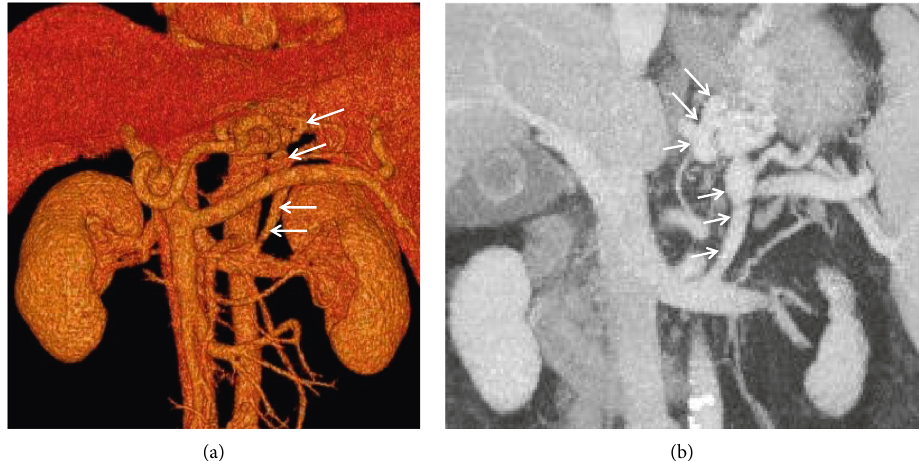
Figure 10: Gastrorenal shunt. A 62-year-old male with a four-year history of unexplained liver cirrhosis presented with recurrent hematemesis. The contrast-enhanced CT scan on the portal vein phase demonstrated that gastrorenal shunt (white arrow) manifested as enhancement of abnormally dilated vessels originating from the gastric vein to the left renal vein. (a) Three-dimensional reconstruction; (b) coronal contrast-enhanced